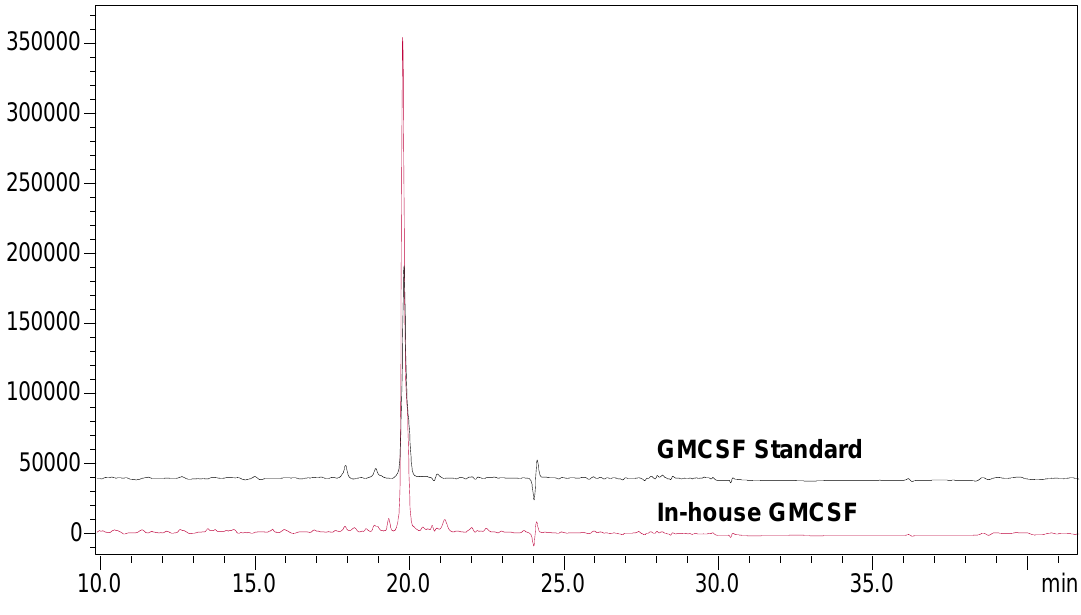
Figure 5. Size Exclusion HPLC profile of standard and in-house purified GMCSF preparations. Size exclusion chromatograph showing comparison of standard GMCSF and in-house purified hGMCSF with optimum mobile phase consisting of 1.15 g di-sodium hydrogen phosphate, 0.2 g of potassium hydrogen phosphate and 23.4 g of sodium chloride. Flow rate was maintained at 0.5 mL/min and detection was at 215 nm. Black line represents standard hGMCSF while red line indicates the in-house purified